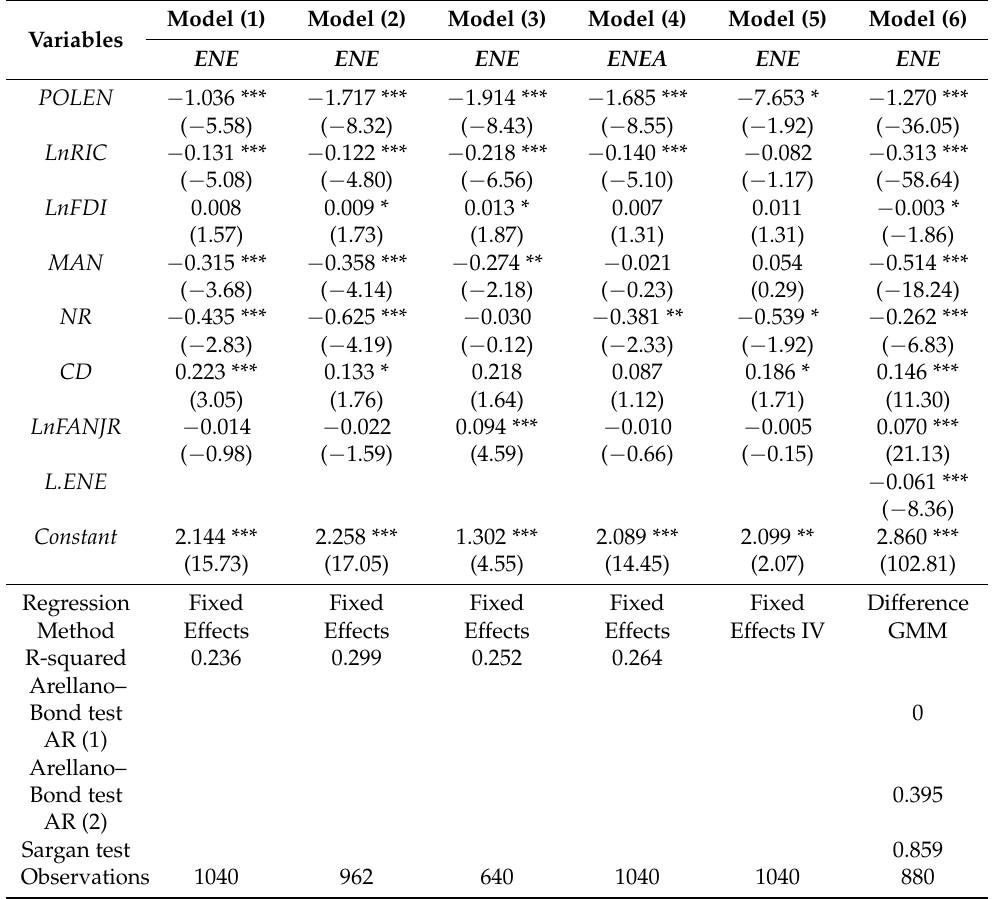
Table 3. Benchmark